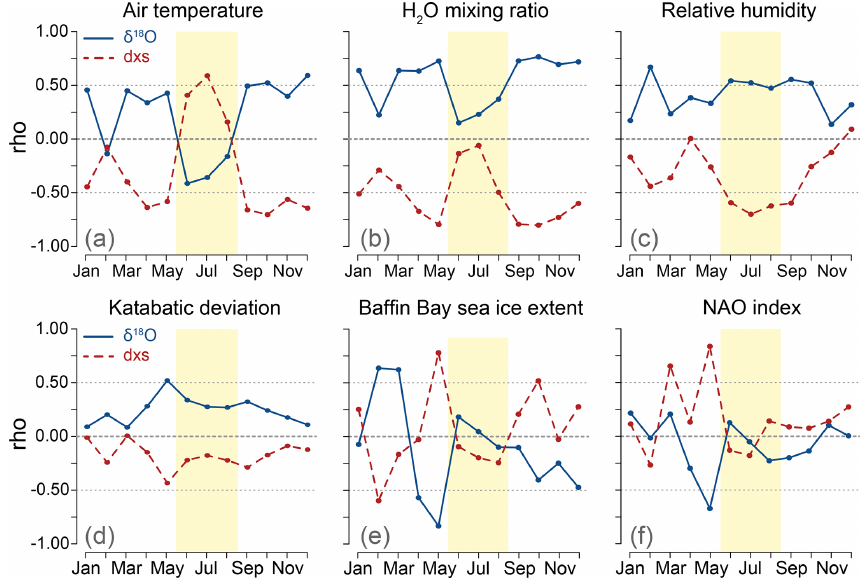
Figure 6. Spearman correlations of meteorological variables (a–f) with δ 18 O (blue solid line) and dxs (red dashed line), with data binned by month. The yellow shading highlights the summer season (JJA) and horizontal dotted lines show ρ values of 0.00 and ± 0 . 50 for reference. Correlation patterns for δ 2 H (not shown) are very similar to those of δ 18 O. Correlation values were calculated using the highest available data resolution, namely 10min for (a–c) , hourly for (d) , and daily for (e, f)